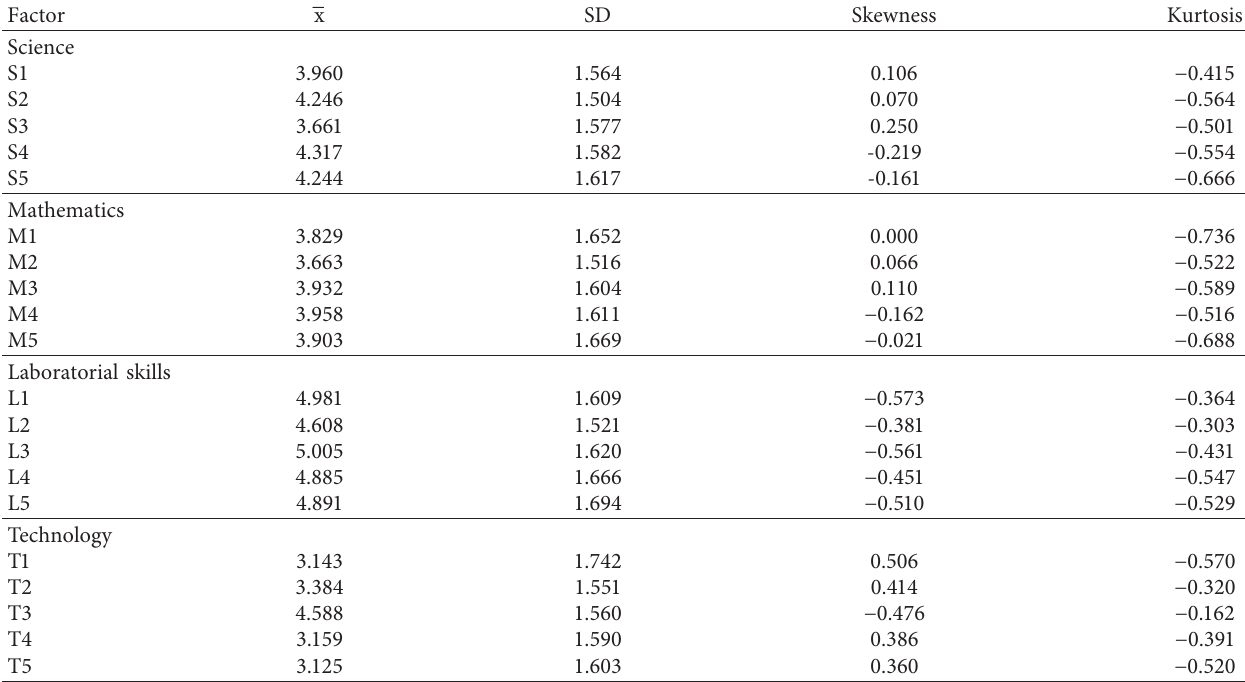
Table 2: The assumptions in statistics of the four factors.